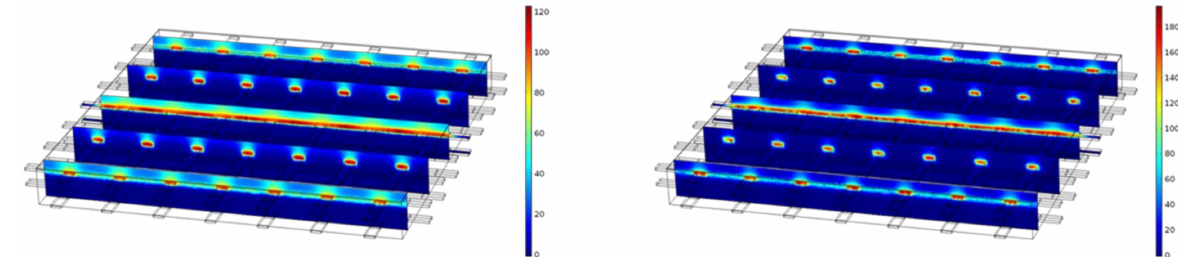
Figure 13. A 3D model of FEM solution for the NaCl concentration at t = 650 d for 0.5 V (left) and 1 V